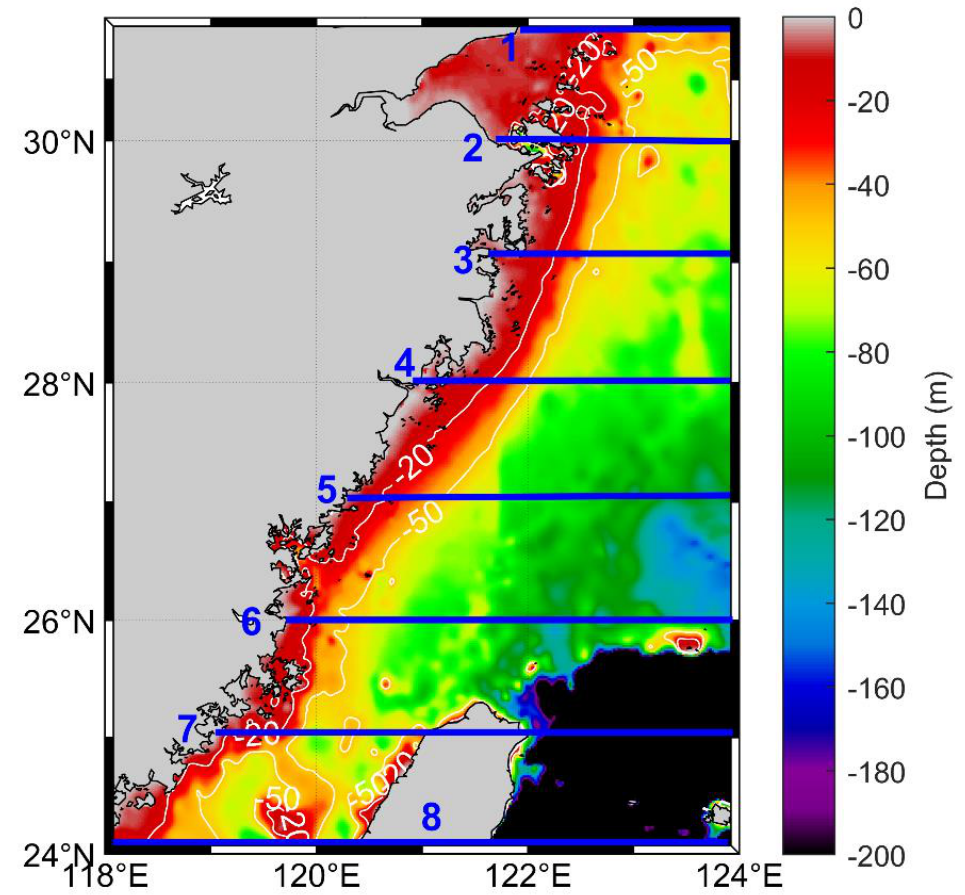
Figure 7. Bathymetry and zonal lines (numbered, blue), along which monthly distributions of SST across the CCF are plotted (Figures 8 and 9). The zonal line numbers correspond to the SST curve numbers in Figures 8 and 9. White lines show the 20 m and 50 m isobaths. The depth scale is cut off at 200 m to show fine details of shallow bathymetry of the shelf.